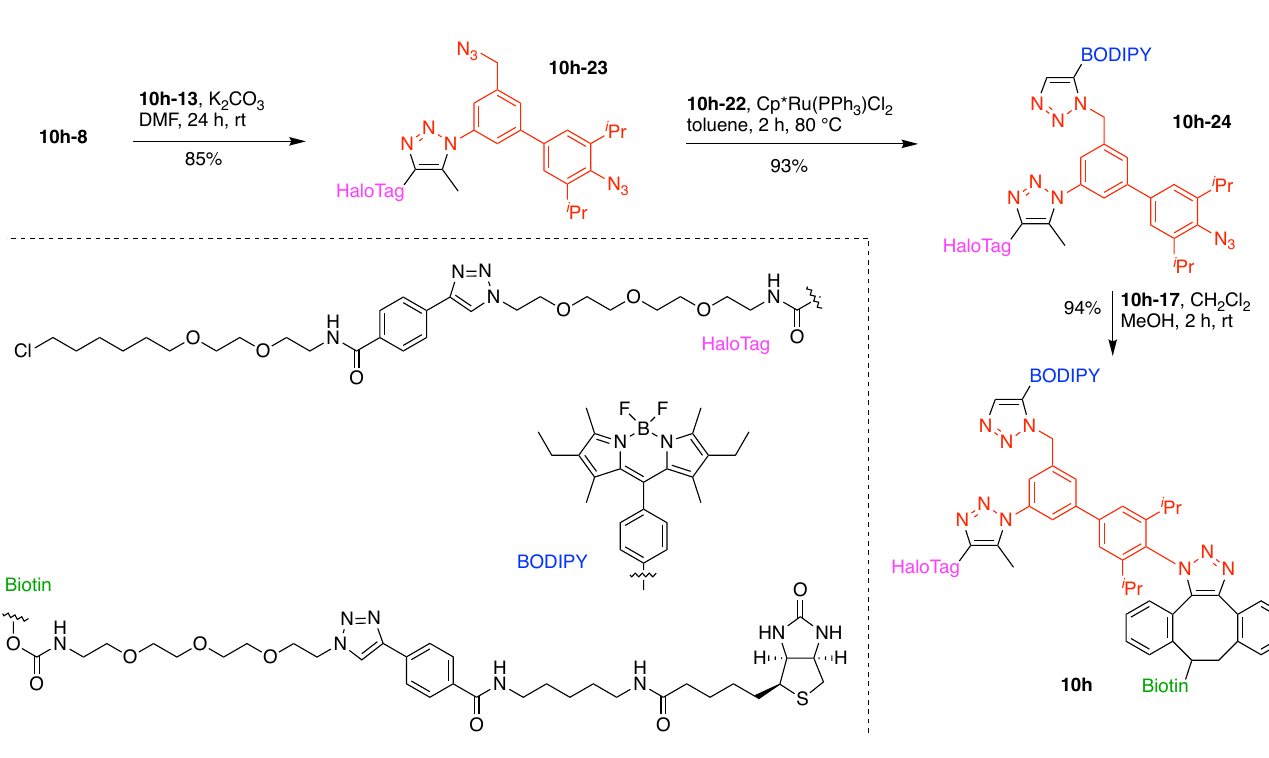
diisopropylphenyl azide reacted with cyclooctyne 10i-4 by strain-promoted azide-alkyne cycloaddition (SPAAC). Last, the 1-adamantyl azide reacted with terminal alkyne 10i-5 by CuAAC. The product tetrakis(triazole) 10i is composed of two benzene hubs and four functional units: (A) a HaloTag as a labeling agent; (B) a BODIPY as a fluorescent